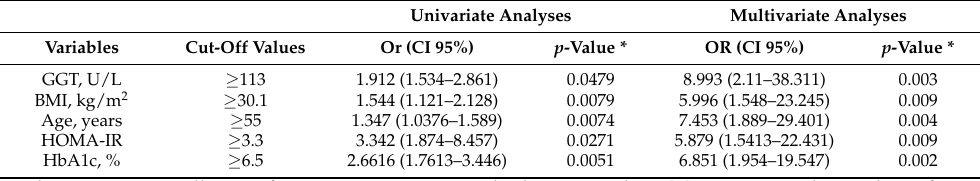
Table 4. Univariate and multivariate analyses for factors related to F3/F4